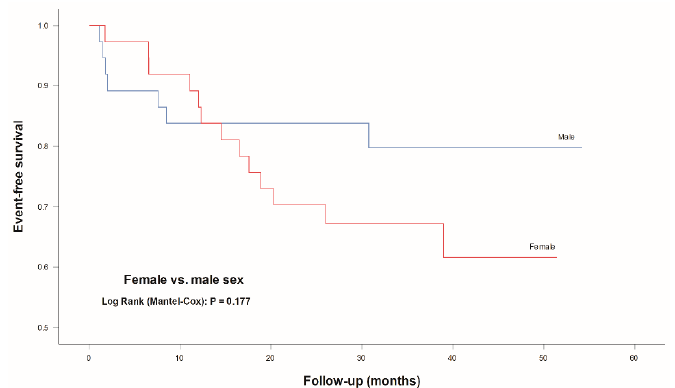
Figure 4. Event-free survival for MACCE according to sex in the propensity score matched cohort. Propensity score matching analysis with a nearest neighbor matching algorithm for age, BMI and eGFR (1:1 allocation and a caliper of 0.01). Legend: MACCE, major adverse cardiovascular and cerebrovascular events (composite of cardiac mortality, ischemic stroke, urgent coronary revascularization and nonfatal myocardial infarction).